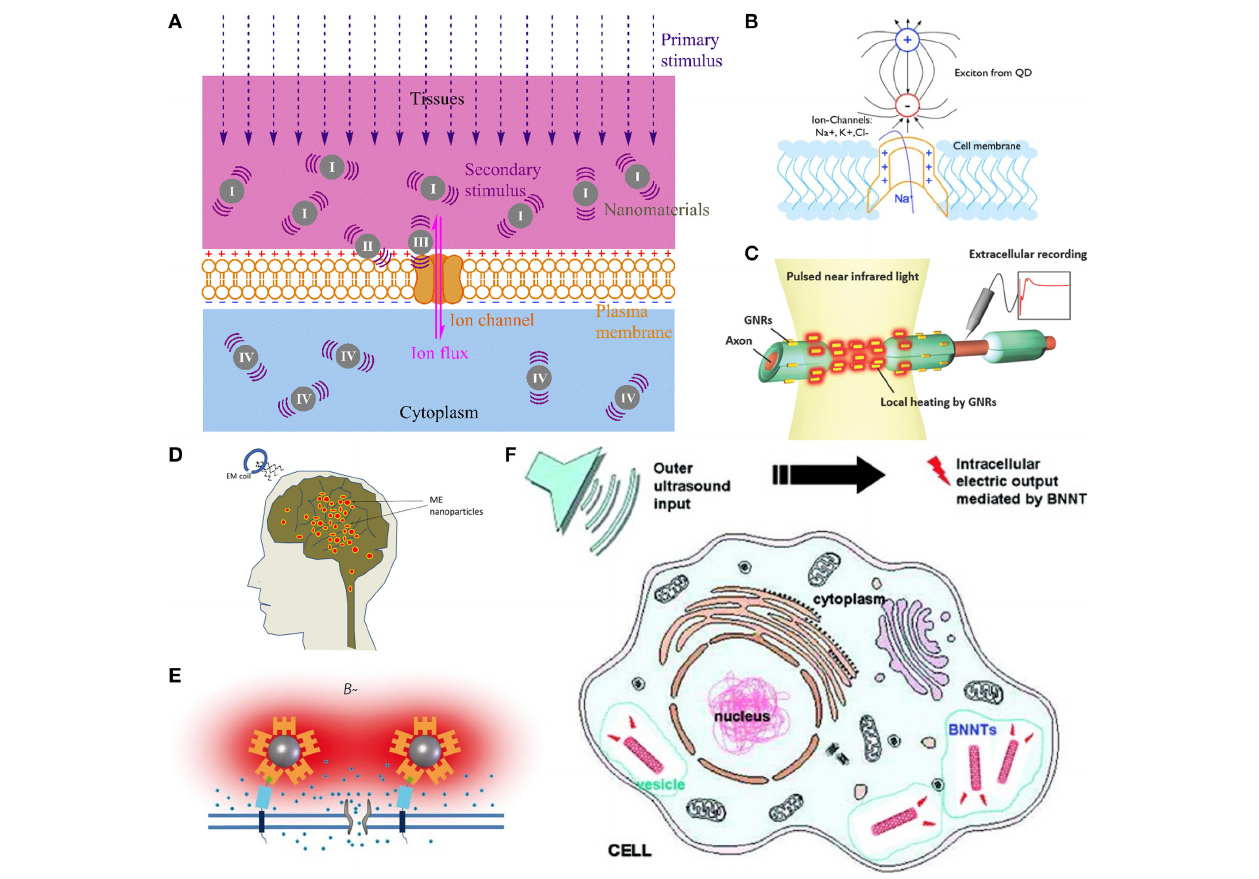
FIGURE 1 | Principles of nanomaterial-enabled neural stimulation. (A) General principle: a wirelessly transmitted primary stimulus, such as light, magnetic fields or ultrasound, penetrates through tissues and is converted by the nanomaterial to a localized secondary stimulus, primarily electric fields or heat, at the nanomaterial-neuron interface, to stimulate the neuron. The nanomaterials are (I) dispersed or immobilized in the extracellular environment, (II) attached to the membrane, (III) bound to the ion channel, or (IV) internalized to the cytoplasm. According to the primary and secondary stimuli, nanomaterial-enabled neural stimulation techniques can be classified into (B) opto-electric stimulation (Lugo et al., 2012), (C) opto-thermal stimulation (Eom et al., 2014), (D) magneto-electric stimulation ( Yue et al., 2012), (E) magneto-thermal stimulation (Huang et al., 2010), and (F) acousto-electric stimulation (Ciofani et al., 2010). (Copyright permissions of B–F were obtained from the